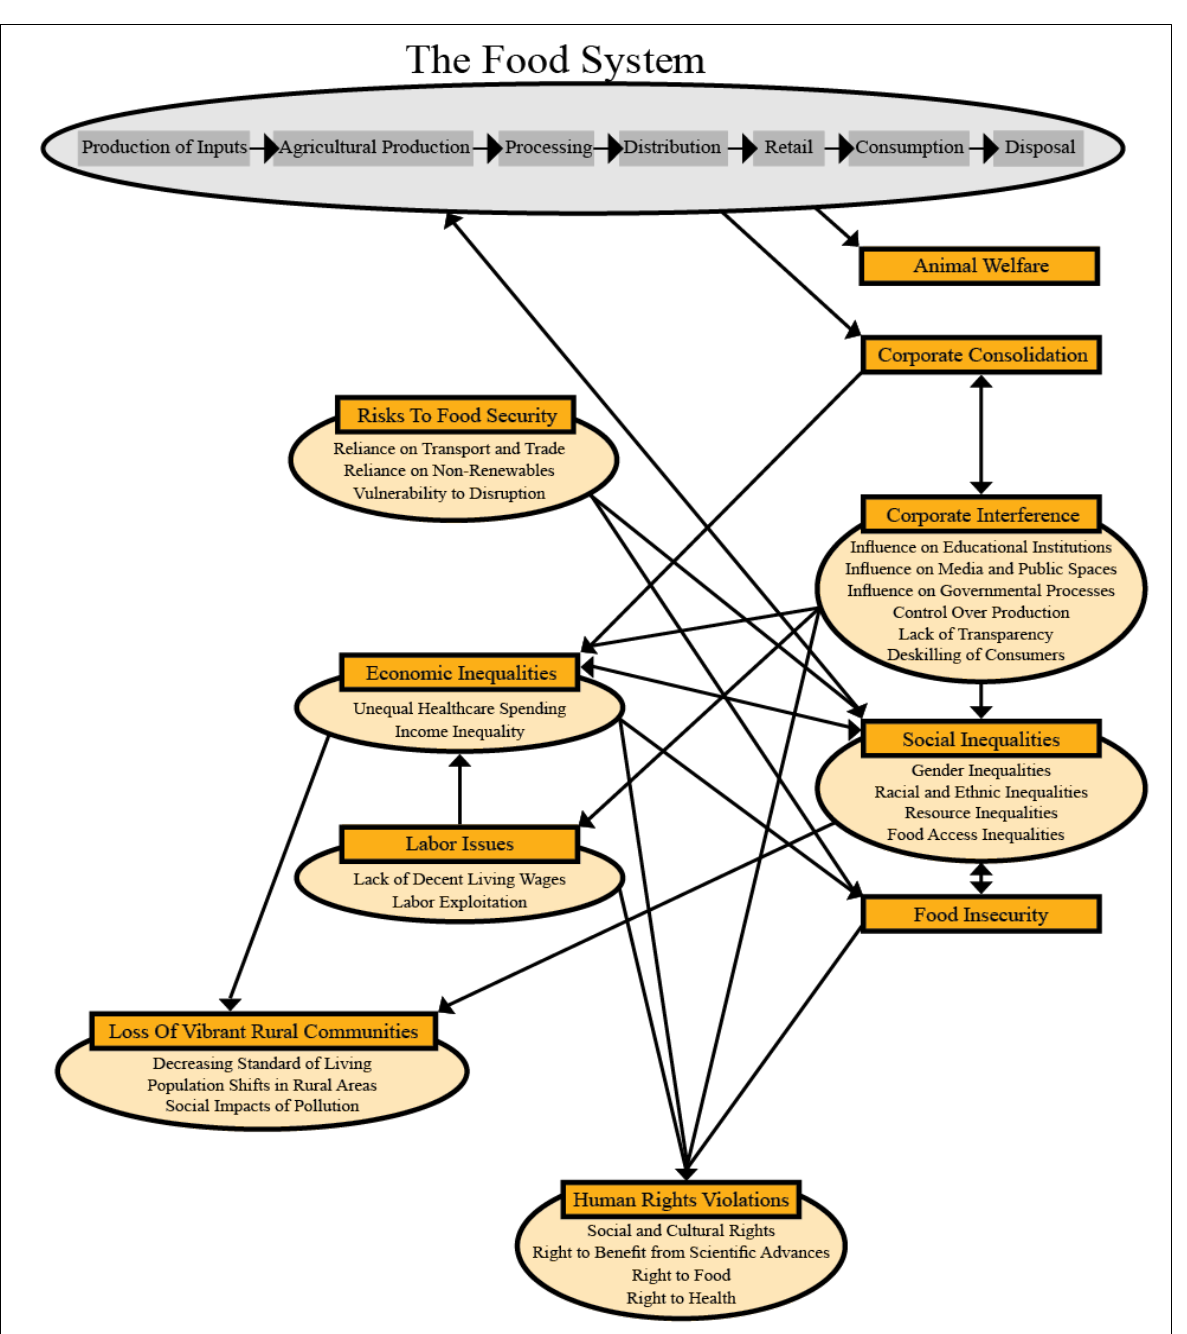
Figure B2. Socio-Economic Outcomes Map of the U.S. Food System, Outcomes Derived from